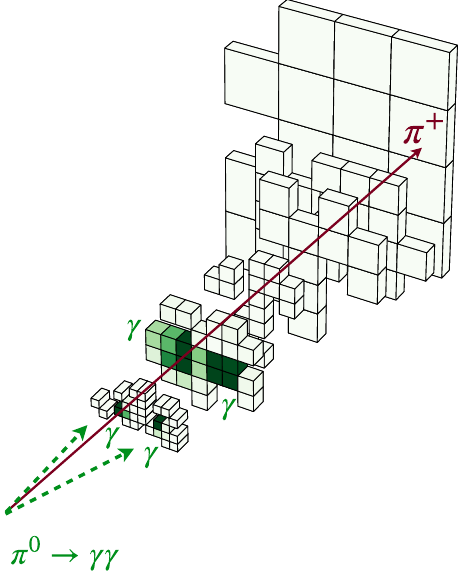
Fig. 1 A 3-D display the energy deposits of π + and π 0 → γγ in the LG calorimeters (left) and of π 0 only (right). The π + track and its extrapolation to the calorimeters is also displayed. Cells, where the fraction of deposited energy from the π + is dominant are illustrated